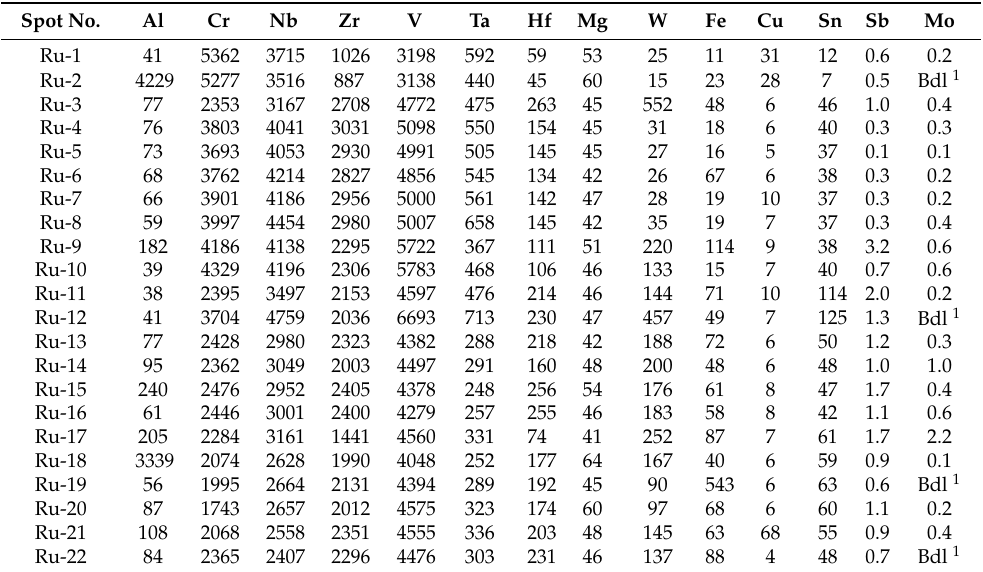
Table 1. Trace element contents (ppm) of rutile inclusions in rubies, Yuanjiang ruby deposit area.